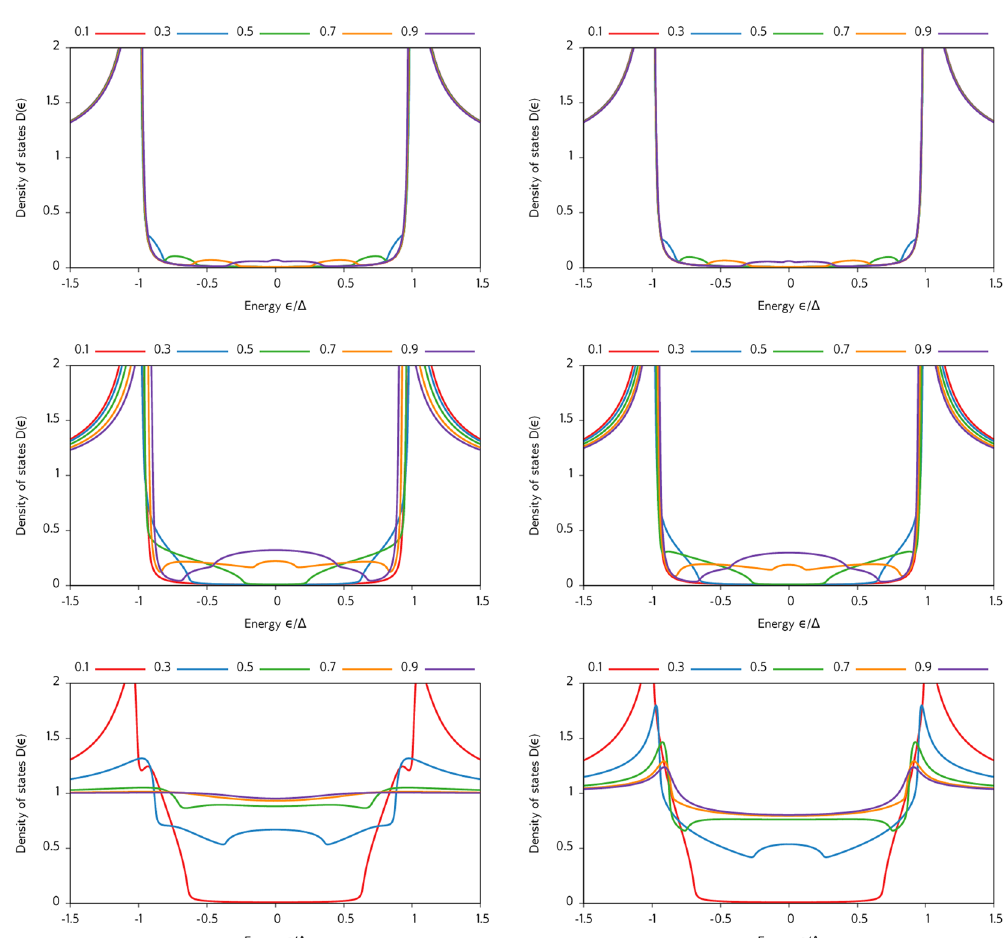
Figure 5. Plots of the DOS of an S/FI bilayer, measured at the superconducting side of the interface. The ferromagnetic insulator is modelled as a fully reflecting spin-active interface, and the superconductor has length L S = ξ S in the left column and L S = 3 ξ S in the right one. The junction has GL S / NG Q ξ S ∈ {300, 30, 3}, decreasing downward. The different curves correspond to different values for the spin-dependent interfacial phase shifts ϕ / π , as shown in the legends above the